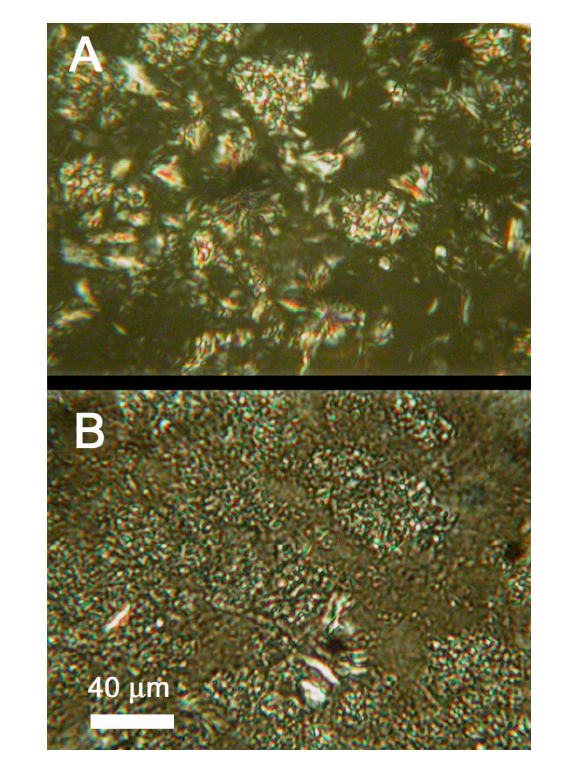
Figure 4: Optical micrographs of a 2 wt % ODA-C /silicone oil gel before (A) and after (B) the application of 10 Pa shear stress for 10 min at 25 °C. The space bar applies to both micrographs.